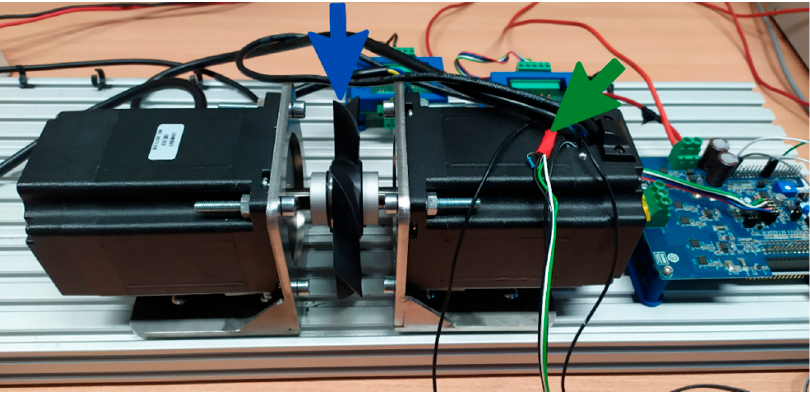
Figure 3. Placement of the cooling fan ( blue arrow ) and the casing temperature sensor ( green arrow ).